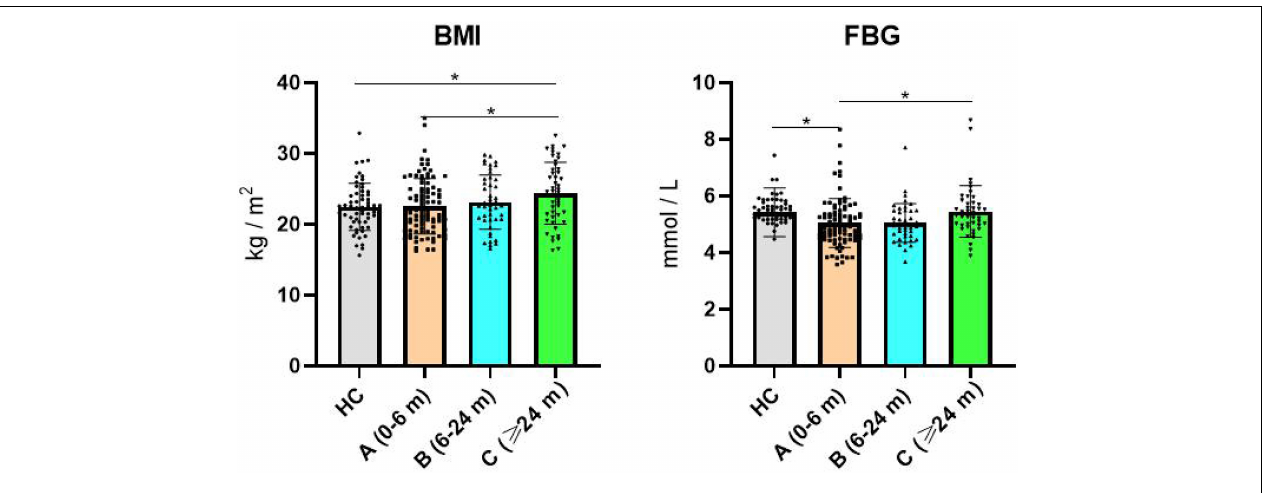
FIGURE 1 | Comparison of BMI and FBG in each group. BMI, body mass index; FBG, fasting blood glucose; (A) schizophrenia (duration < 6 months); (B) schizophrenia (6 months ≤ duration < 24 months); (C) schizophrenia (duration ≥ 24 months). *Indicates p <